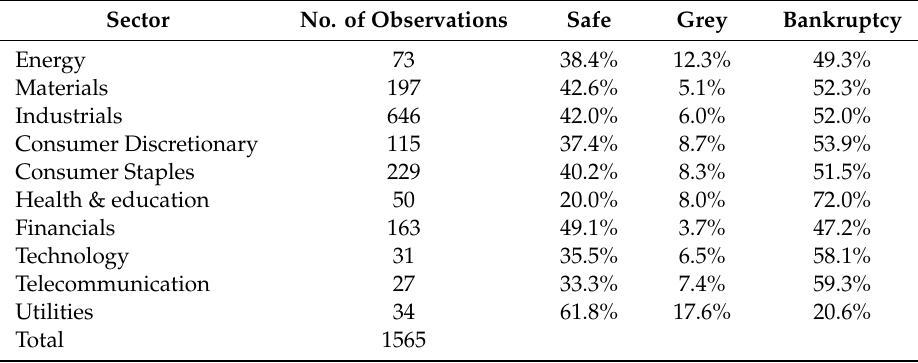
Table 10. Overall Distance to Default in all sectors for GFC (2007–2009).